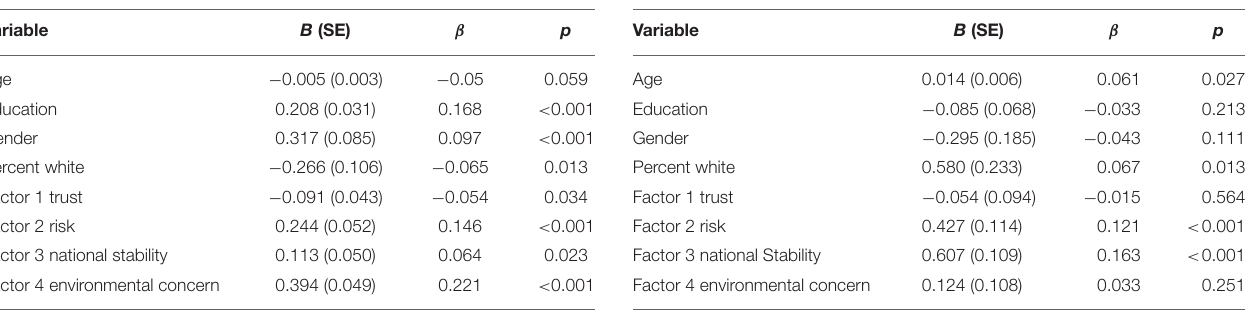
TABLE 4 | Predictors of number of entities with facility siting veto